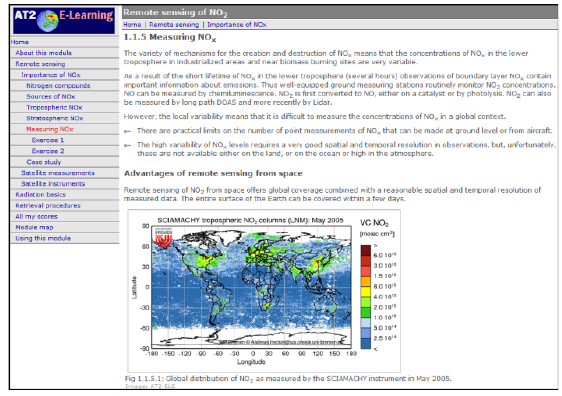
Figure 3: ACCENT – Measuring nitrogen oxides